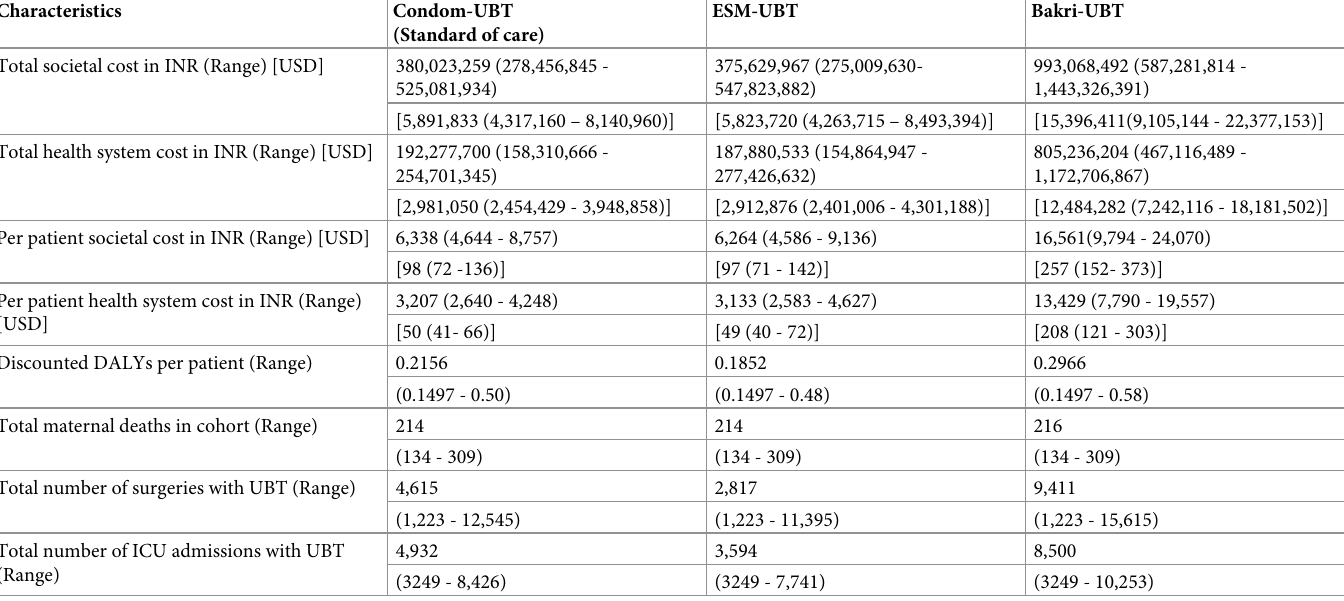
Table 2. Costs and outcomes with UBT devices for atonic PPH management in Indian public health system. Characteristics